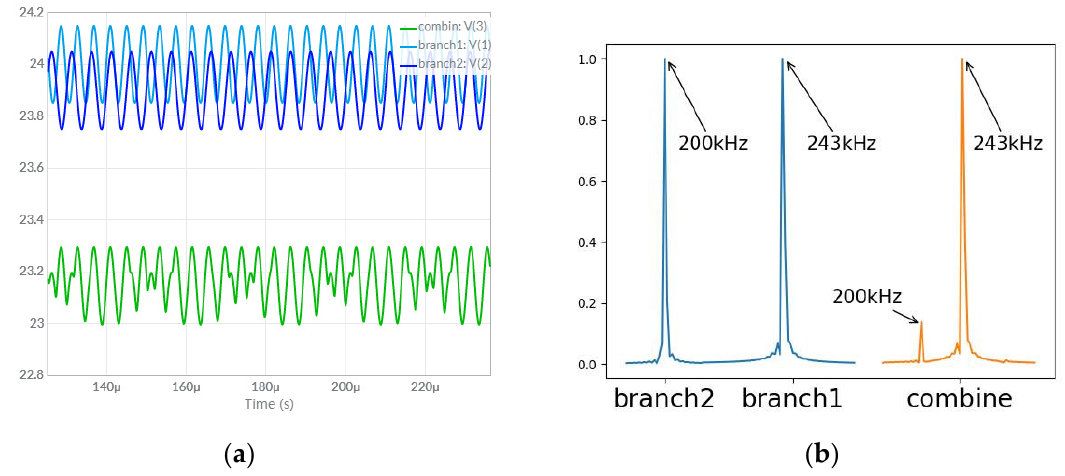
Figure 3. ( a ) Voltage waves in a diode-based simple parallel redundant system with two SMPSs; ( b ) The spectrum of three voltage waves.